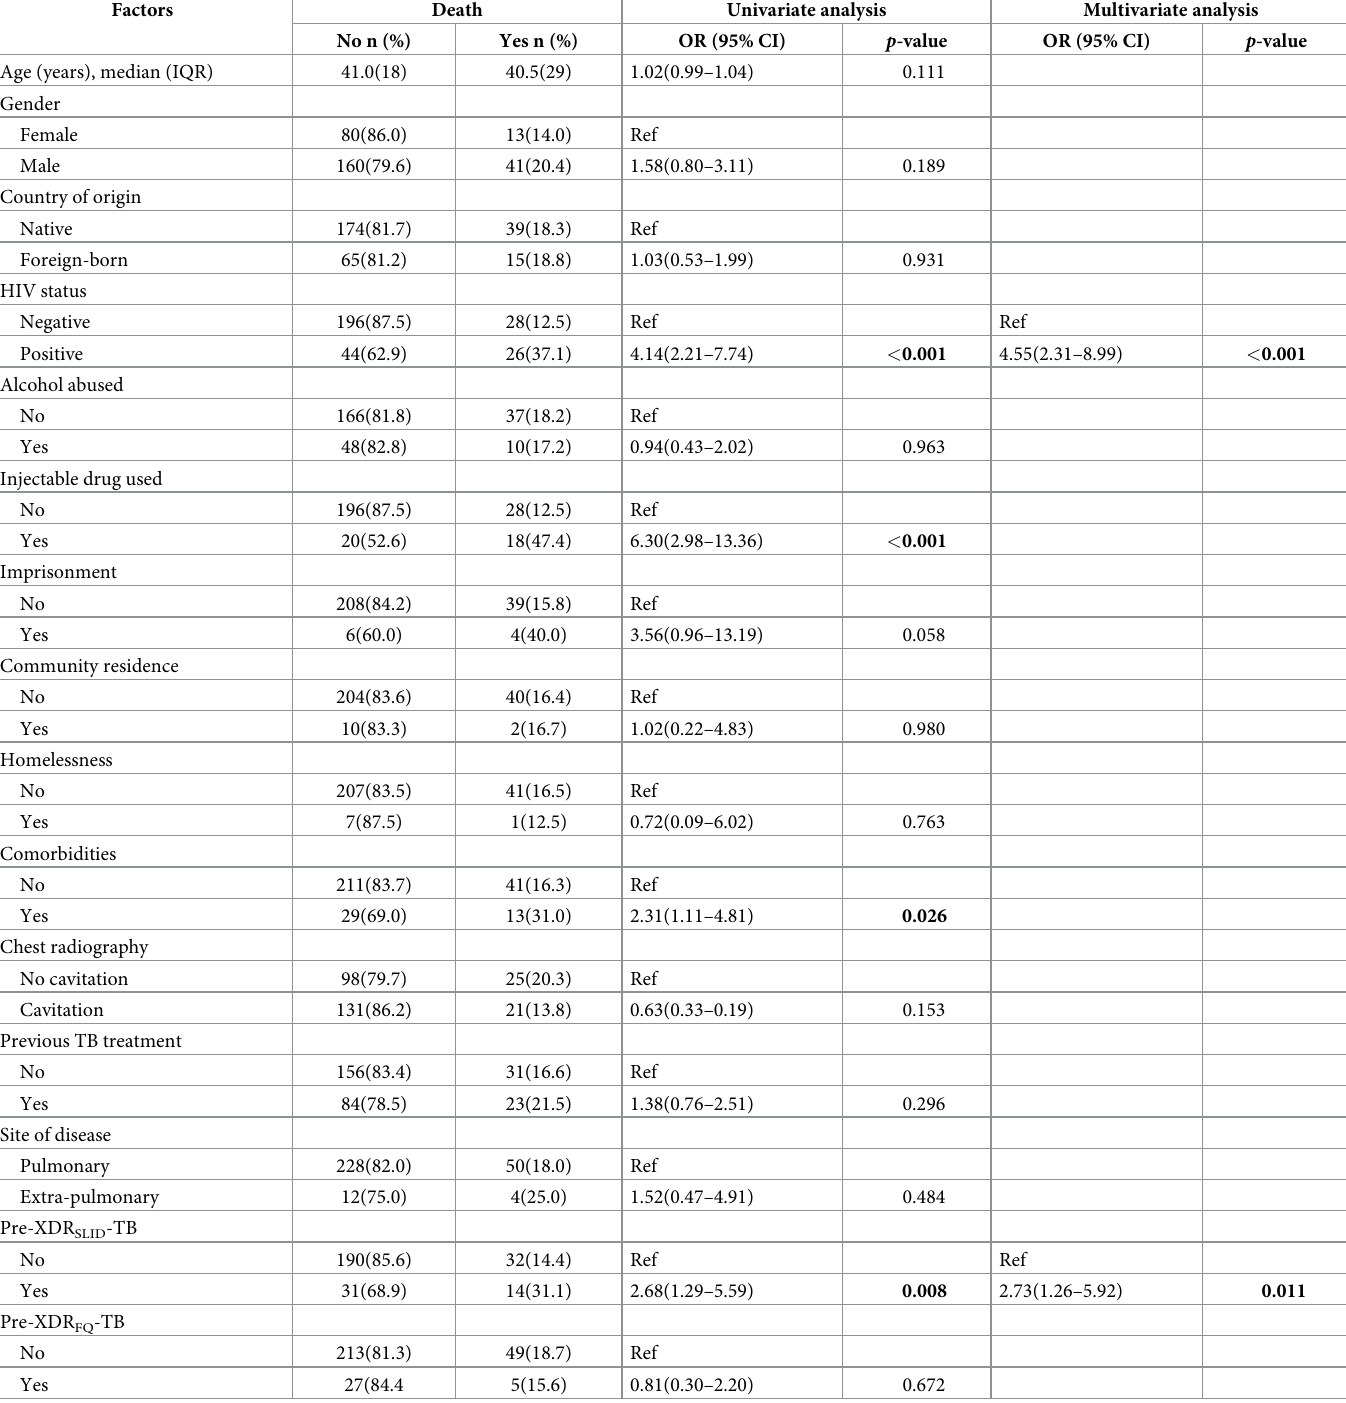
Table 3. Factors associated with death among patients with multidrug-resistant tuberculosis (n =